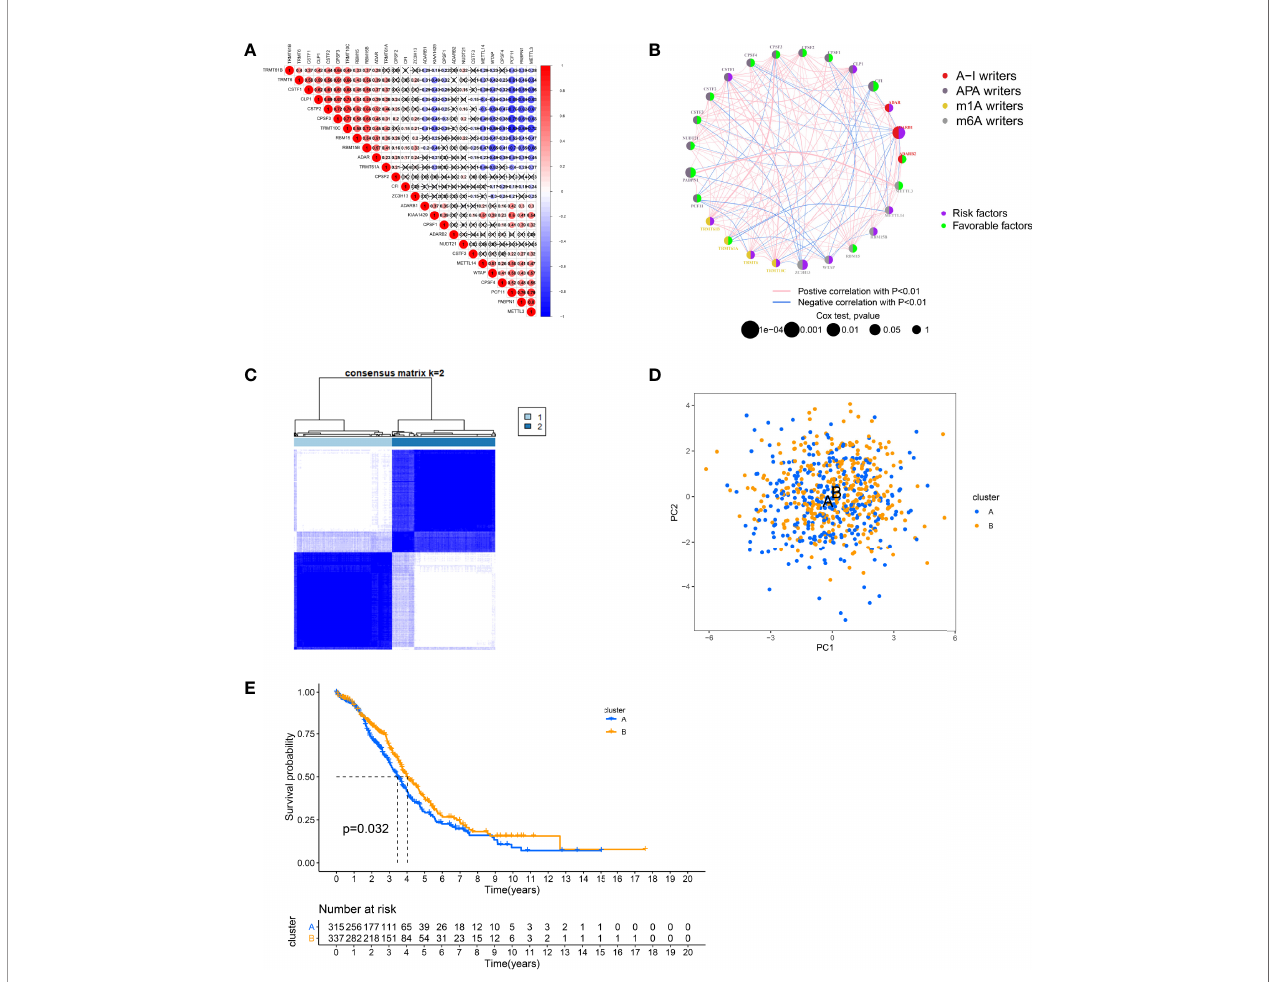
FIGURE 2 | Patterns of RNA modi fi cation and clinical characteristics divided by consistent clustering. (A) Heatmap shows positive (red) and negative (blue) correlations among RNA modi fi cation “ writers ” in ovarian cancer (OC). (B) Interactions among RNA modi fi cation “ writers ” in OC. (C) Unsupervised clustering of RNA modi fi cation “ writers ” and Consensus matrix heatmaps for k = 2. (D) Principal component analysis (PCA) showing a remarkable difference in transcriptomes between different modi fi cation patterns. (E) Kaplan – Meier curves for the two RNA modi fi cation patterns of OC